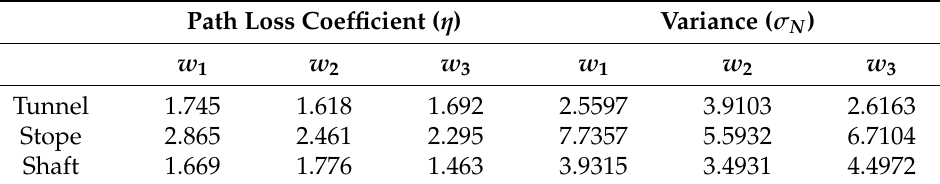
Least Squares Fit w = 0.5 m Measured w = 0.5 m Least Squares Fit w = 1.5 m Measured w = 1.5 m Least Squares Fit w = 2.5 m Measured w = 2.5 m